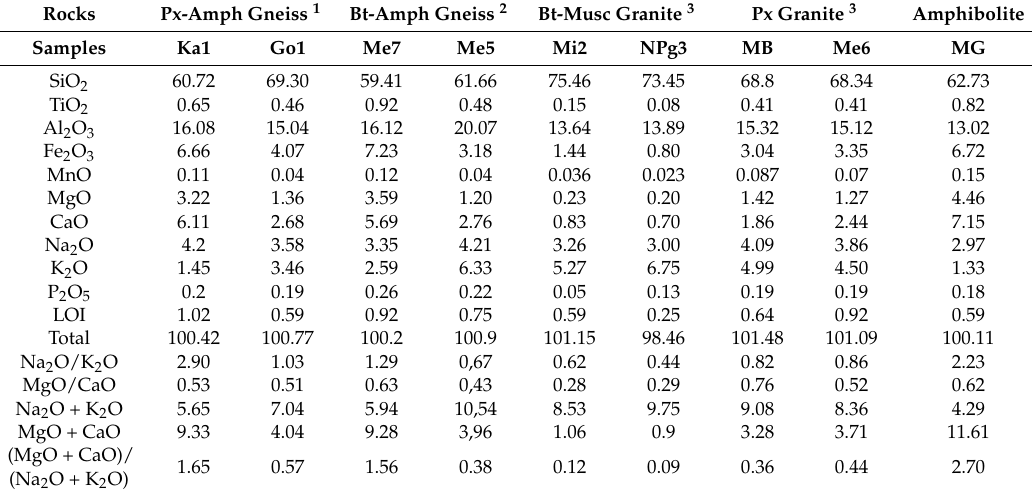
Table 1. Chemical analyses of sample rocks typical of the studied area.